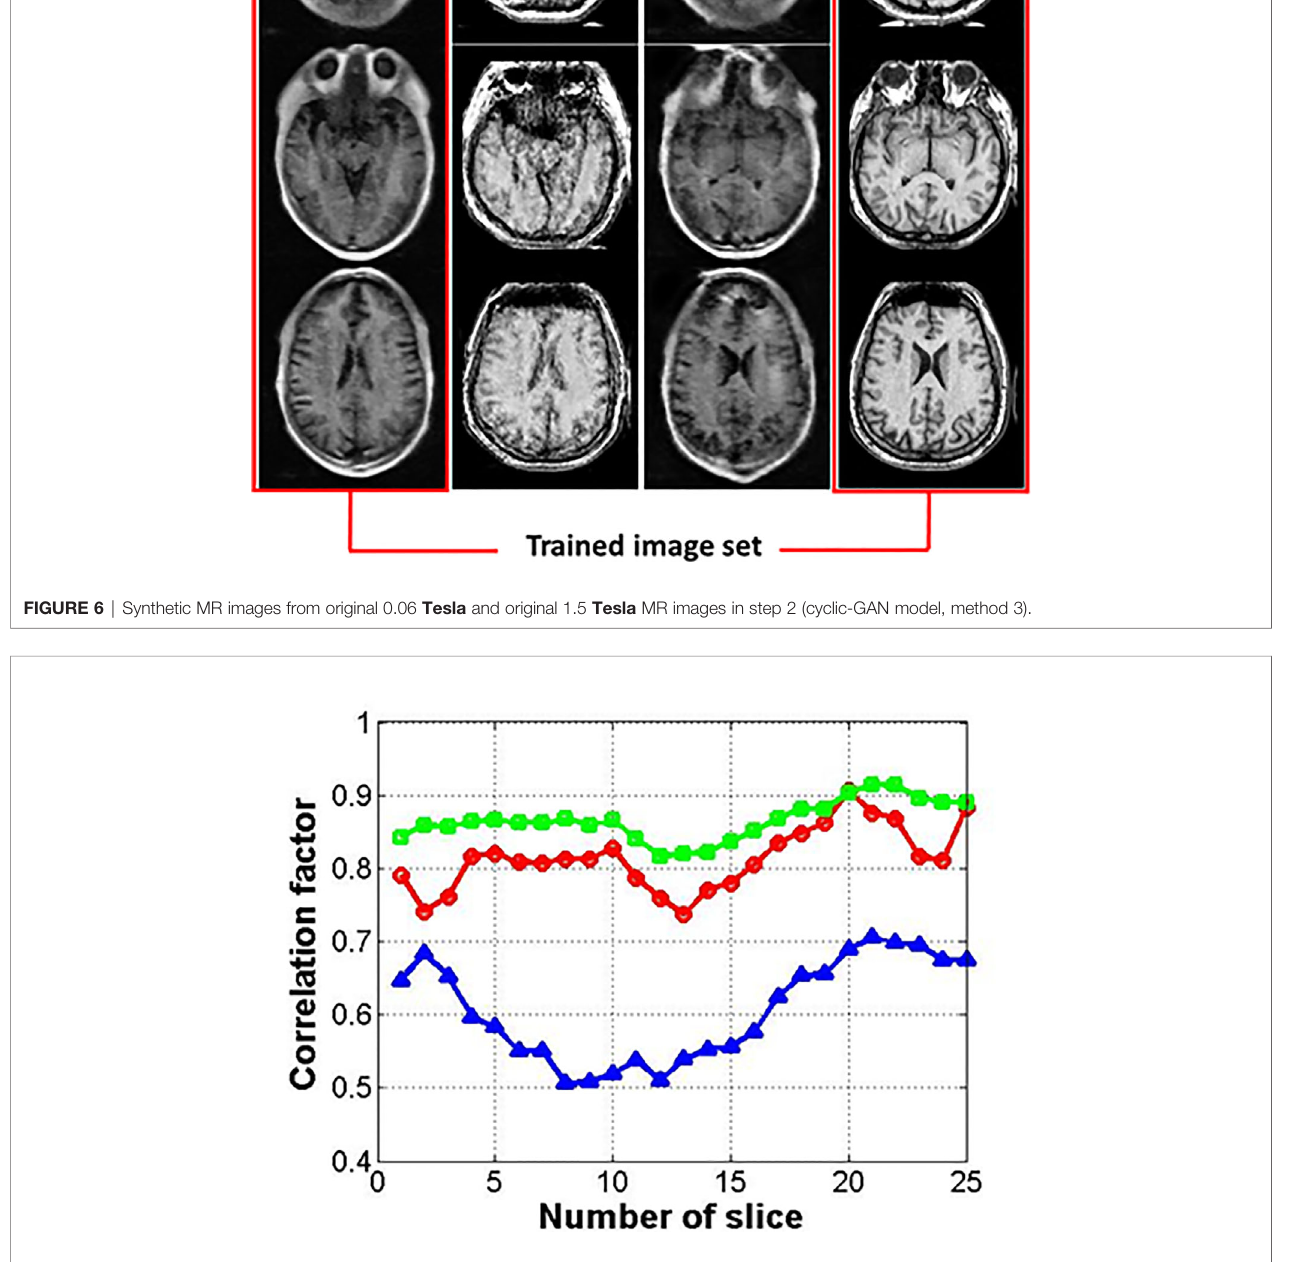
FIGURE 7 | Correlation factor between input and reference images (circle, square, and triangle marks indicate deformed image, synthetic image from deformed one, and original one,